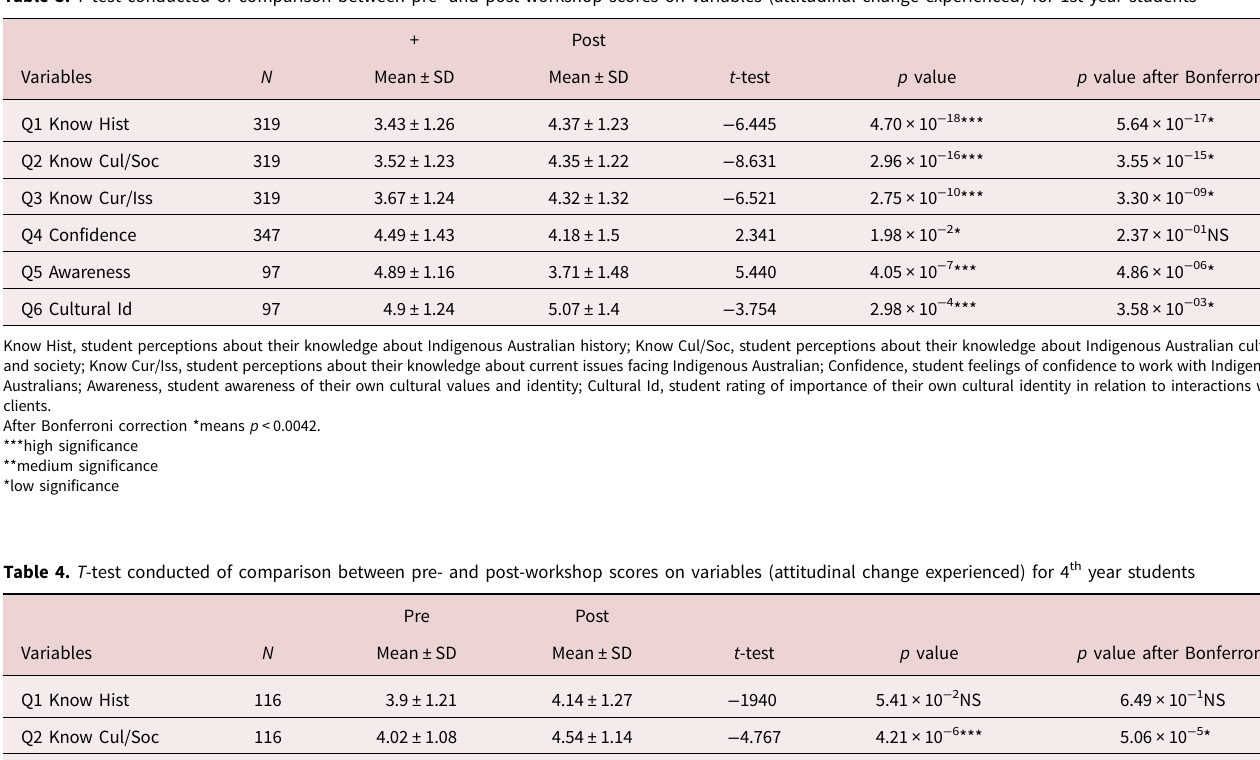
Table 3. T -test conducted of comparison between pre- and post-workshop scores on variables (attitudinal change experienced) for 1st year students